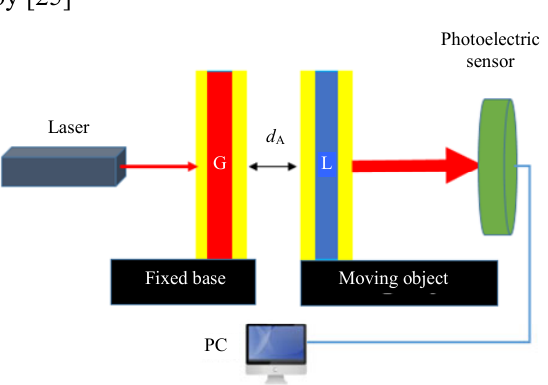
Fig. 1 Schematic of the displacement